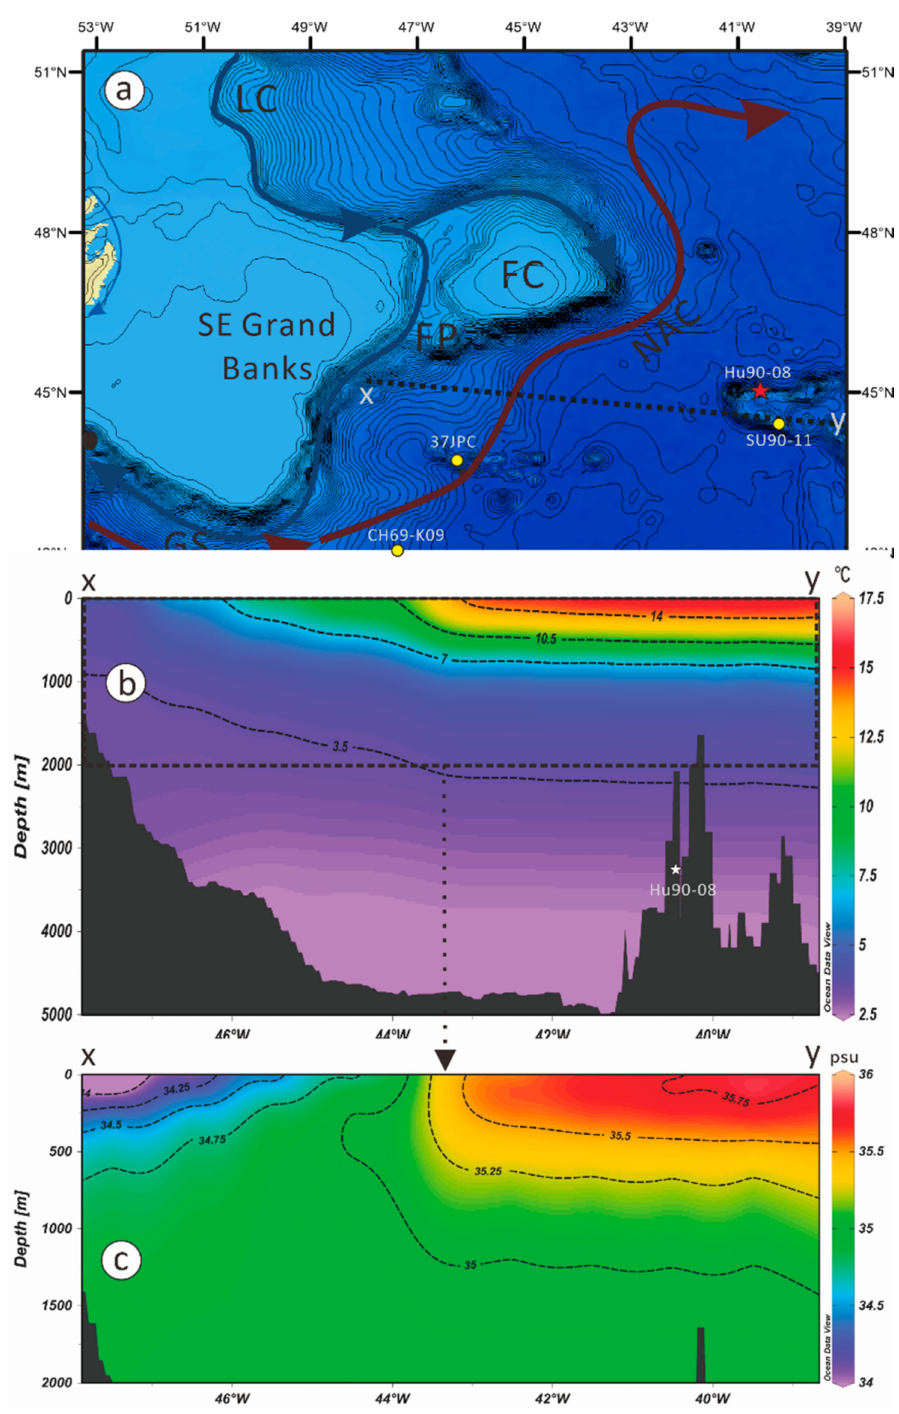
Figure 2. ( a ) enlarged bathymetric map of the SE Grand Banks, SW Labrador Sea, and Newfoundland Basin. The location of the published records of a few cores used in the study is shown by the yellow dots, whereas the position of the sediment core Hu9007-08 (this study) is shown by the red star. ( b ) sea-surface temperature distribution on the SE Grand Banks on the X-Y transect is shown in Figure 2a. ( c ) sea-surface salinity along the X-Y section, which demonstrates the low salinity Labrador Current (west), whereas the position of the North Atlantic Current is shown by the high salinity (east). Note LC = Labrador Current; GS = Gulf Stream; NAC = North Atlantic Current; FC = Flemish Cap; and FP = Flemish Pass. Figure 2b,c were plotted using the Ocean Data View software